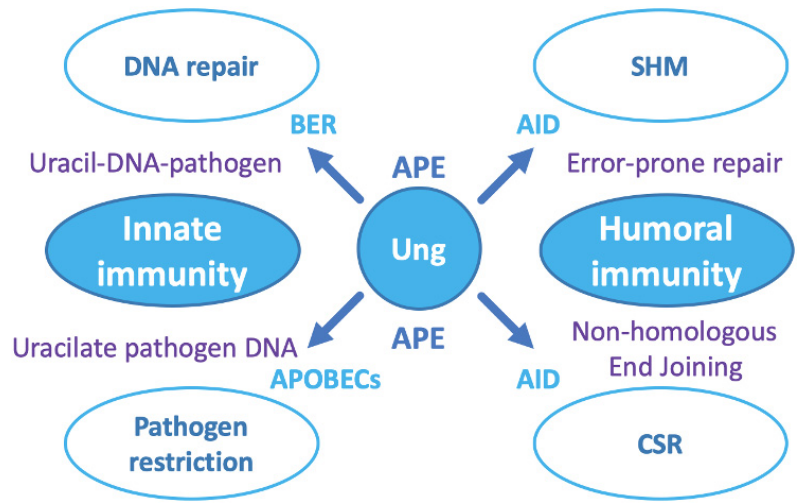
Figure 4. The roles of Ung in cellular programs. On the left side of the schematic: Innate cellular immunity. Ung acts upon spontaneously arising or enzymatically generated uracil residues. For random chemical events, Ung initiates DNA repair by base excision repair (BER); in the pathogen response, UDG follows APOBEC3 enzymes that deaminate cytosine in pathogen DNA to cause hyperuracilation. On the right side of the schematic: Development of humoral immunity. Ung acts downstream of the cytidine deaminase AID, which generates uracil residues in (i) Immunoglobulin variable chain regions to initiate somatic hyper mutation (SHM), generating variable chain diversity; and (ii) immunoglobulin class switch regions to initiate class switch recombination (CSR), permitting successful antibody variable chains to be deployed via alternative antibody scaffolds, e.g., IgM to IgG. The role of Ung and APE are the same as in BER, but the different pathways (error-prone repair, or non-homologous end joining) deploy alternative suites of proteins downstream to create the intended outcome.